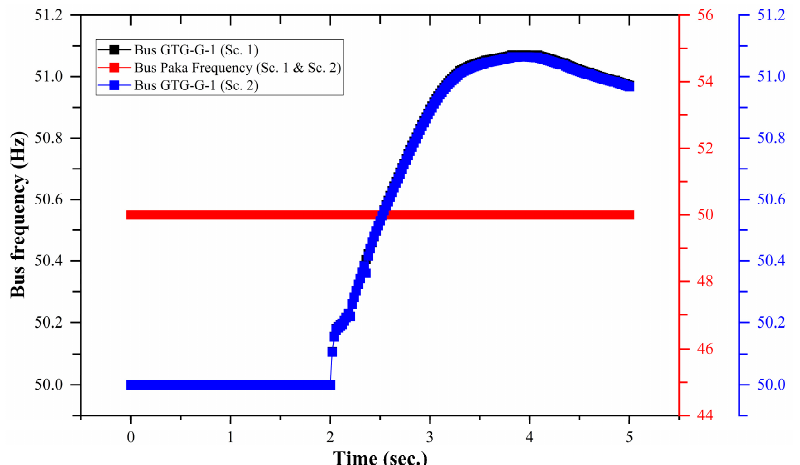
Figure 13. Bus frequency of the test system for over frequency (Scenario 1 and Scenario 2).